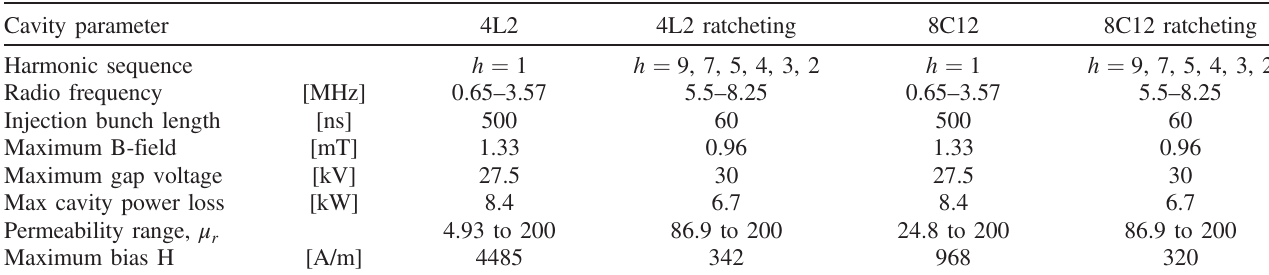
¼ 0 . 5 μ H, for stray